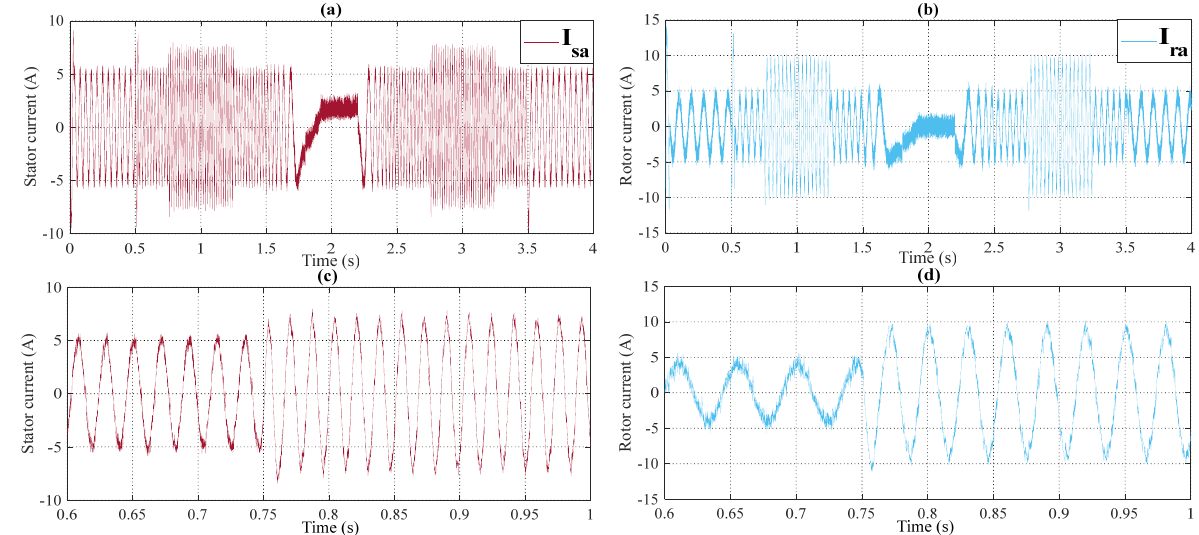
17 of 26 Figure 12. Torque responses of classical DTC and intelligent ACO-DTC.